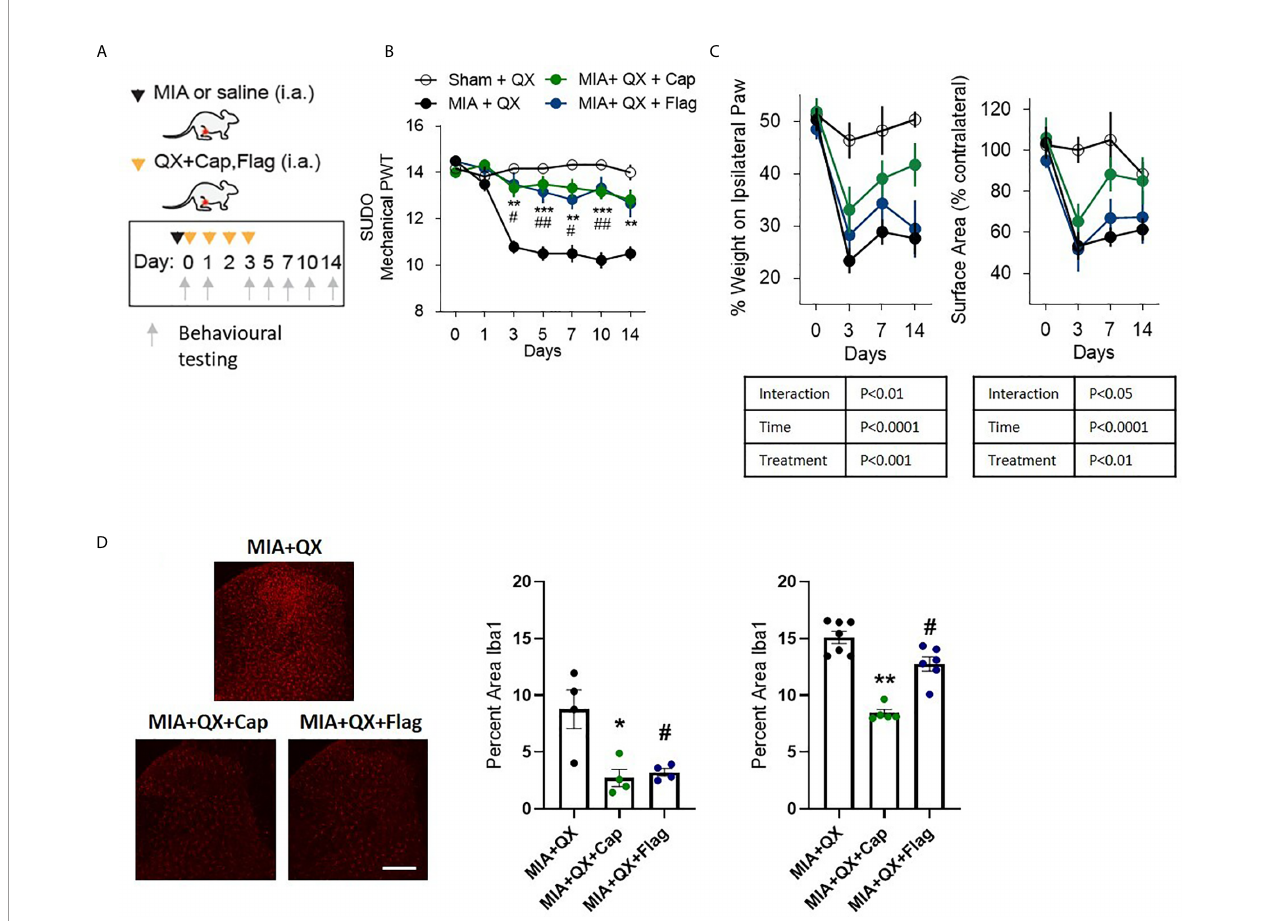
FIGURE 3 | A and C primary afferent activity contributes to mechanical allodynia and spinal microglial response. (A) Schematic diagram for MIA, QX-314 (QX, 2%/ 25 m L) alone, and co-administration of QX and capsaicin (QX + Cap, 10 m g), and fl agellin (QX + Flag, 1 m g). (B) Mechanical withdrawal thresholds after MIA injections in QX, QX + Cap and QX + Flag (N=6 to 7 animals per group). (C) Effects of QX + Cap and QX + Flag on dynamic weight bearing behaviours after MIA injections (N=6 to 7 animals per group). (D) Representative image of Iba1 immunoreactivity in the ipsilateral dorsal horn 7 days after MIA injections in QX, QX + Cap and QX + Flag treated animals. Scale bar = 200 m m. (E, F) Quanti fi cation of Iba1 immunoreactivity at day 7 (E) and day14 (F) after MIA injections in QX, QX + Cap and QX + Flag treated animals (N=4 to 7 animals per group). *P < 0.05, **P < 0.01, ***P < 0.001 comparisons between QX and QX + Cap, # P < 0.05, ## P < 0.01, comparisons between QX and QX +